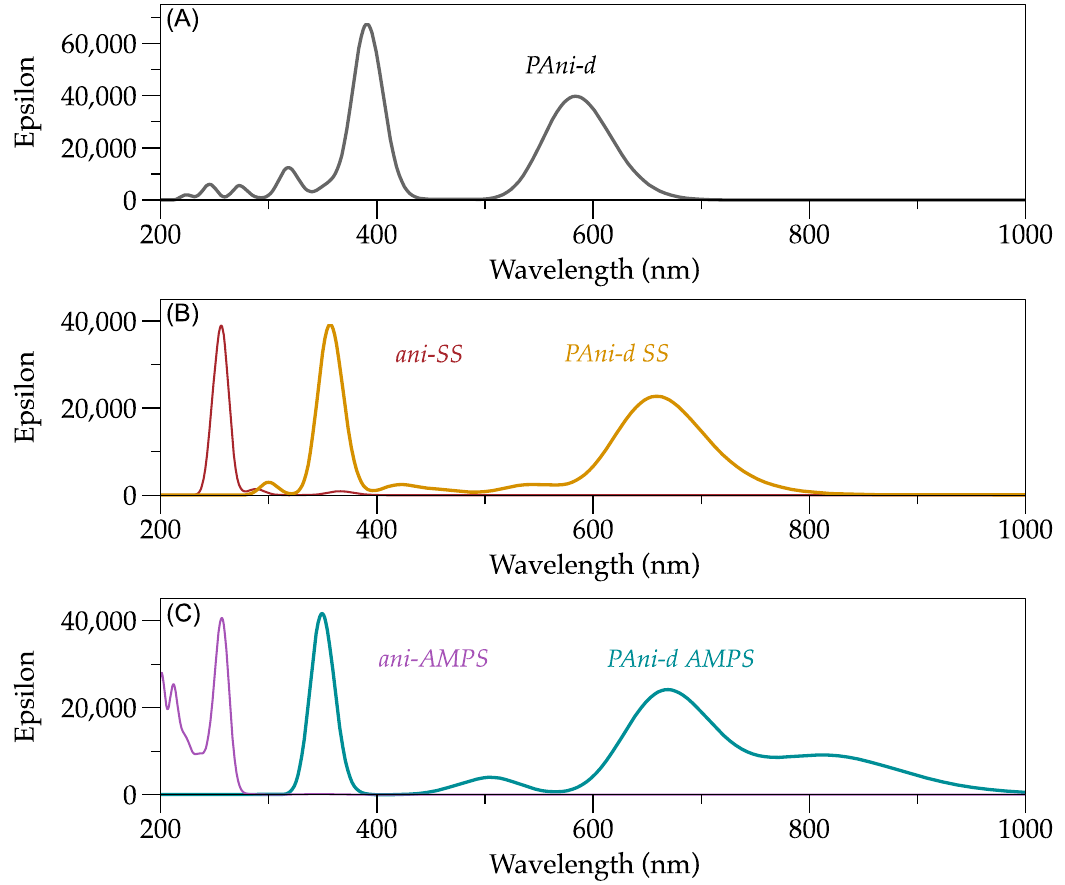
Figure 6. Theoretical UV-Vis spectra. ( A ) PAni-d; ( B ) ani-SS and PAni-d SS; ( C ) ani-AMPS and PAni-d AMPS.